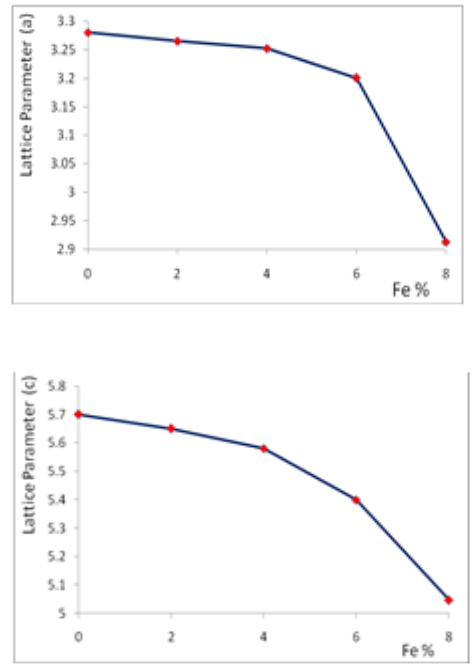
Fig.4: The variation of Lattice parameter for ZnO thin film with Fe doping